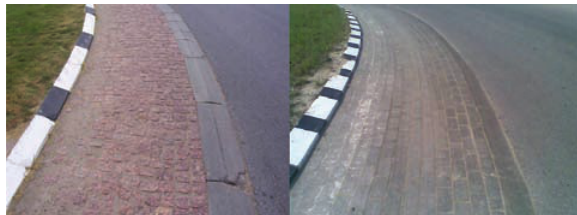
Fig. 13. The damaged road kerbs by riding up on the block- paved circle, the broken inner road kerbs at joints When laying road pavement structures one shall keep